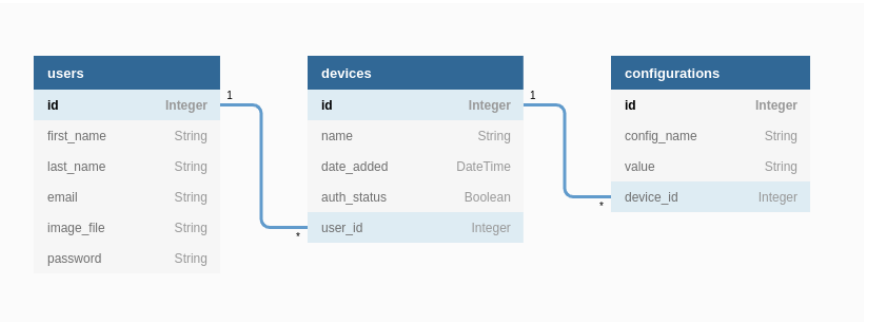
Figure 9. UML diagram of the SQL